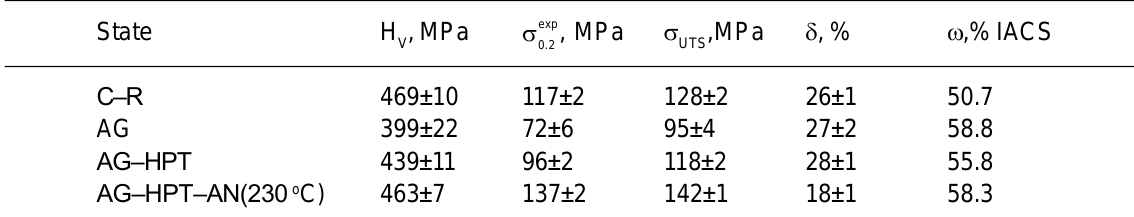
Table 3. Mechanical and electrical properties of Al–0.4Zr (wt.%) alloy.